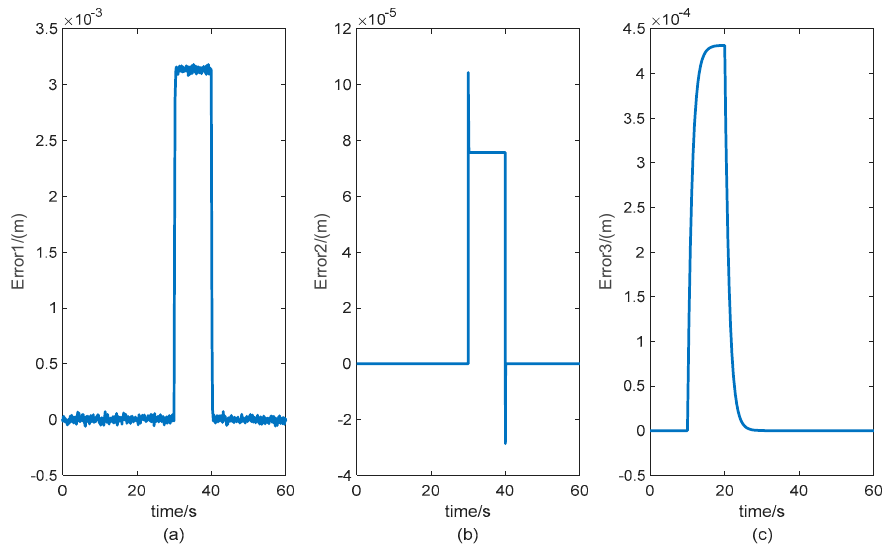
Figure 6. Curves of the faults. ( a ) Curve of fault of Agent 1. ( b ) Curve of fault of Agent 2. ( c ) Curve of fault of Agent 3.